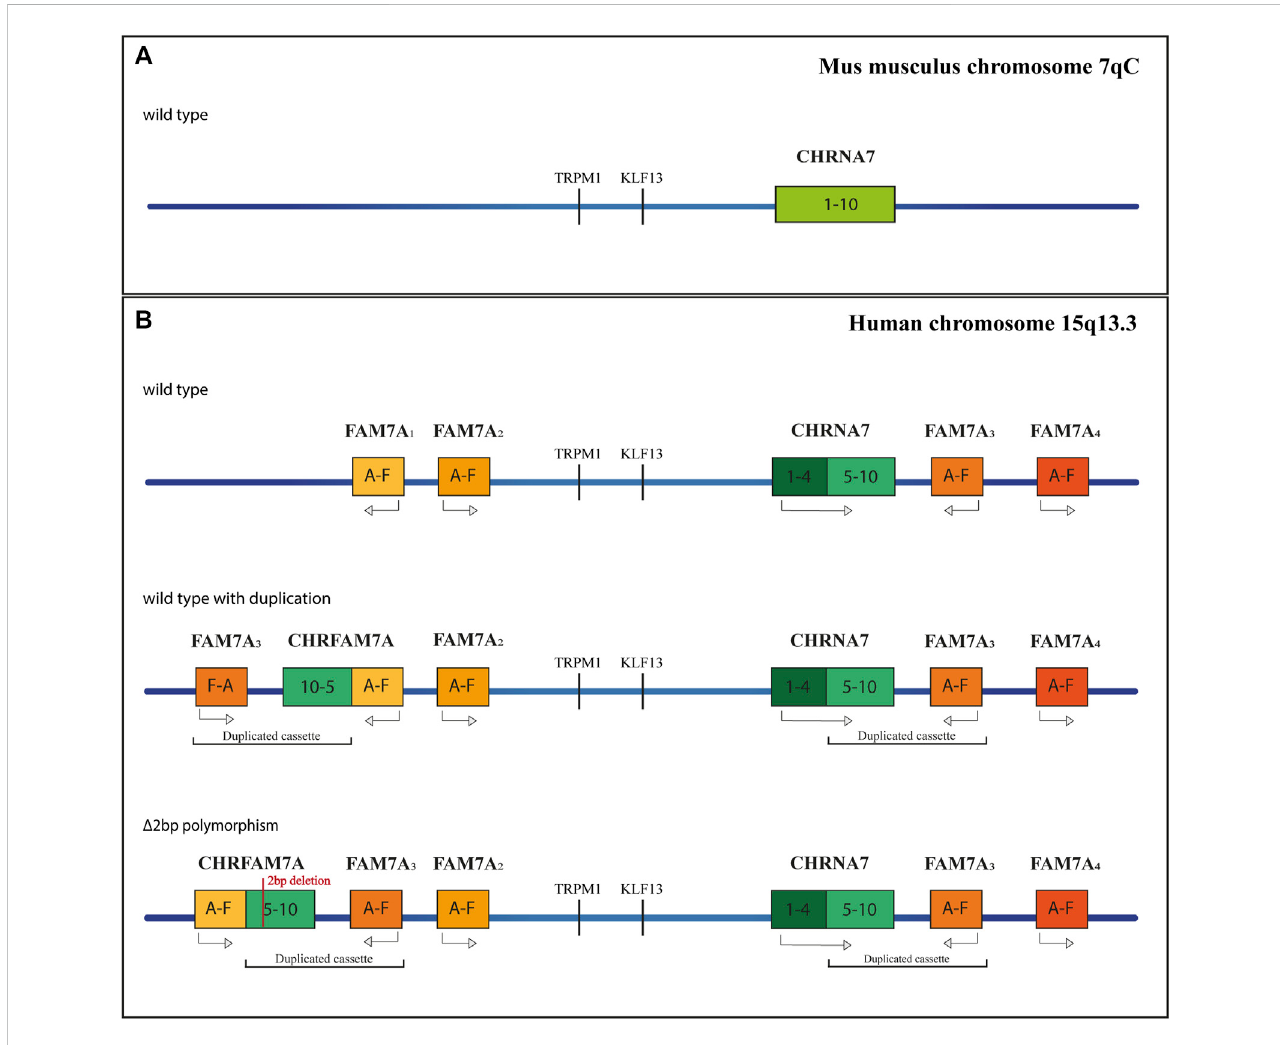
Schematic representation of the CHRNA7 locus. (A) Orthologus locus in mus musculus, at the 7qC chromosome. (B) Different genetic pro fi les of the human Chromosome 15q13.3, without duplication, with the chimeric gene and with the 2bp mutation.